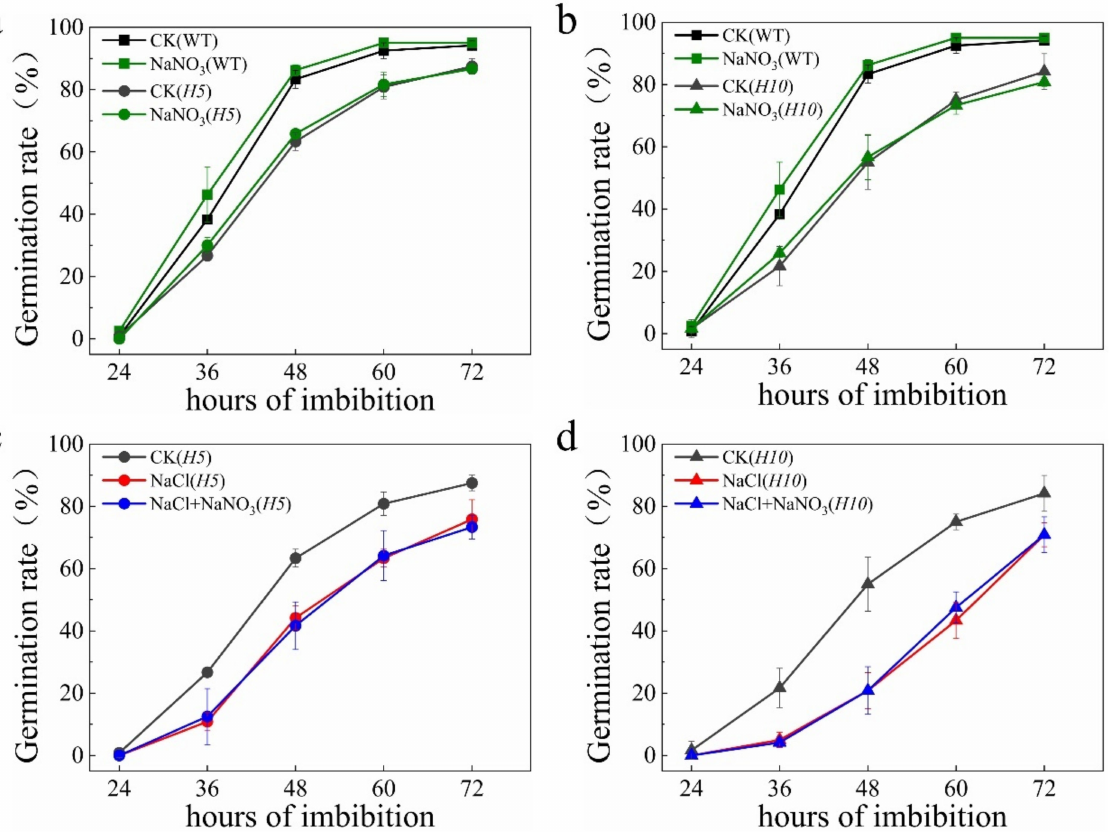
Figure 6. Nitrate-promoted seed germination under salt stress was blocked in triple mutants. ( a , b ) Seed germination of H5 and H10 under treatments of water and 1 mM NaNO 3 ; ( c , d ) Seed germination of H5 and H10 under treatments of NaCl and NaCl plus NaNO 3 . The data are the means of three independent replications ( n = 50) ±